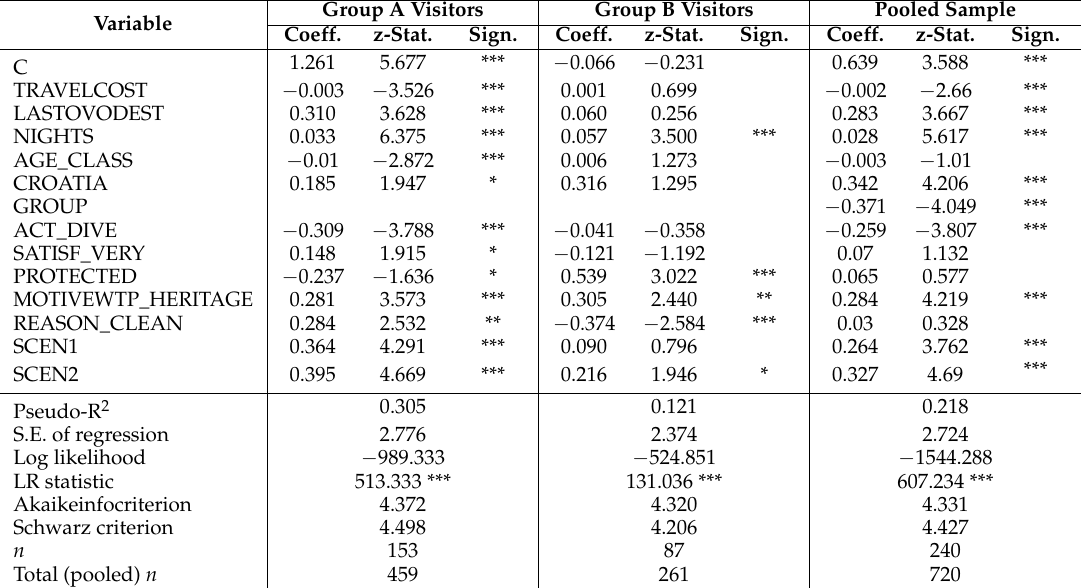
Table 5. Econometric results: travel frequency of different visitor groups to Lastovo Islands. Group A Visitors Group B Visitors Pooled Sample Variable Coeff. z-Stat. Sign. Coeff. z-Stat. Sign. Coeff. z-Stat. Sign. C